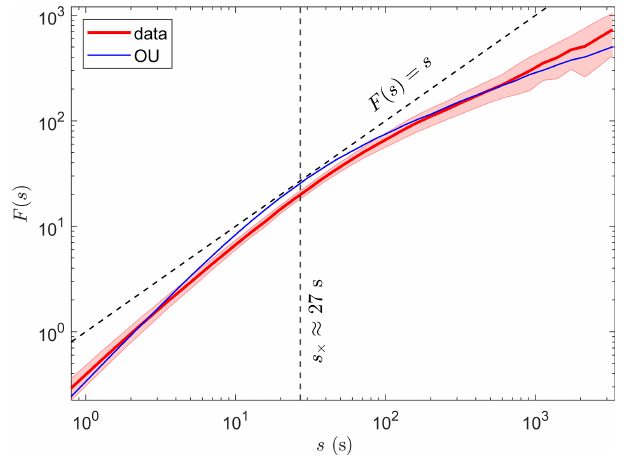
Figure 6. The detrended fluctuation analysis of all 1h time series of carbon dioxide fluxes. The Reynolds average time is set to 5min to calculate fluxes. The sample-averaged fluctuation function is shown by the red line and uncertainties estimated by the standard deviation are shown by the red shading. The fitted fluctuation function of the OU process is shown by the blue line. The fitted parameters are a = 0 . 2, b = 0 . 7, and (cid:49)t = 0 . 1s. The vertical broken line indicates the crossover scale estimated by Eq. (10). For comparison, the function of F(s) = s is also shown by the broken